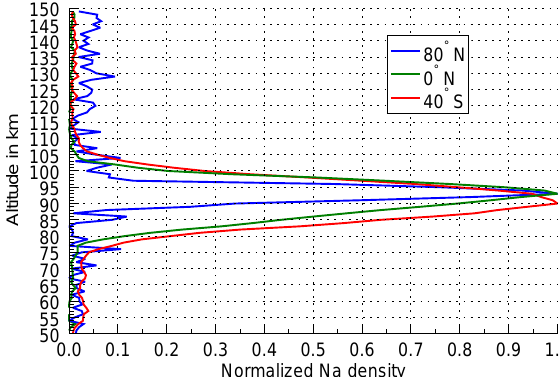
Figure 16. Normalized vertical Na profile at selected latitudes in July. The densities are normalized to the peak